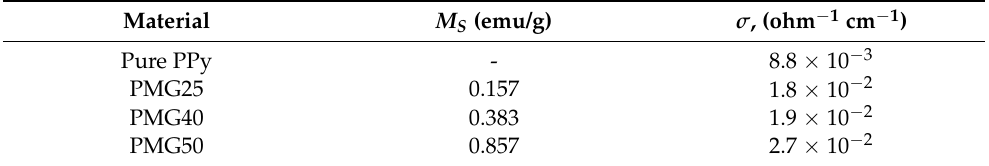
Figure 4. Hysteresis loops of the studied PMG composites at different ratios. Table 1. Magnetic and electrical properties of PPy and PMG